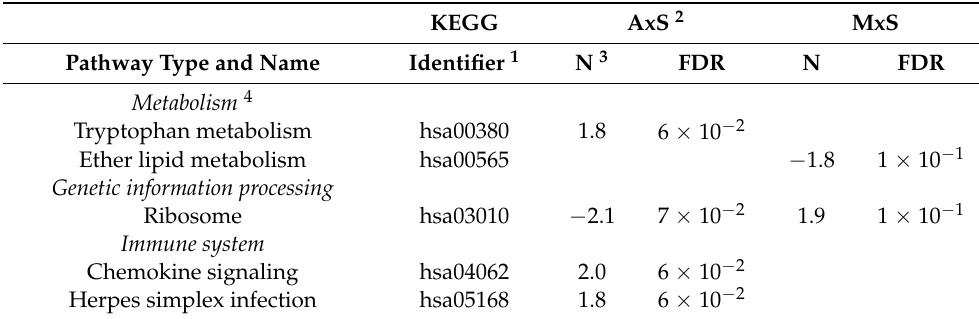
Enriched pathways (Gene Set Enrichment Analysis False Discovery Rate-adjusted p -value < 0.1 and normalized enrichment score absolute value |NES| > 1.5) among genes profiles presenting effects of sex (S) alone or interacting with morphine (M) or maternal immune activation (A) in the prefrontal